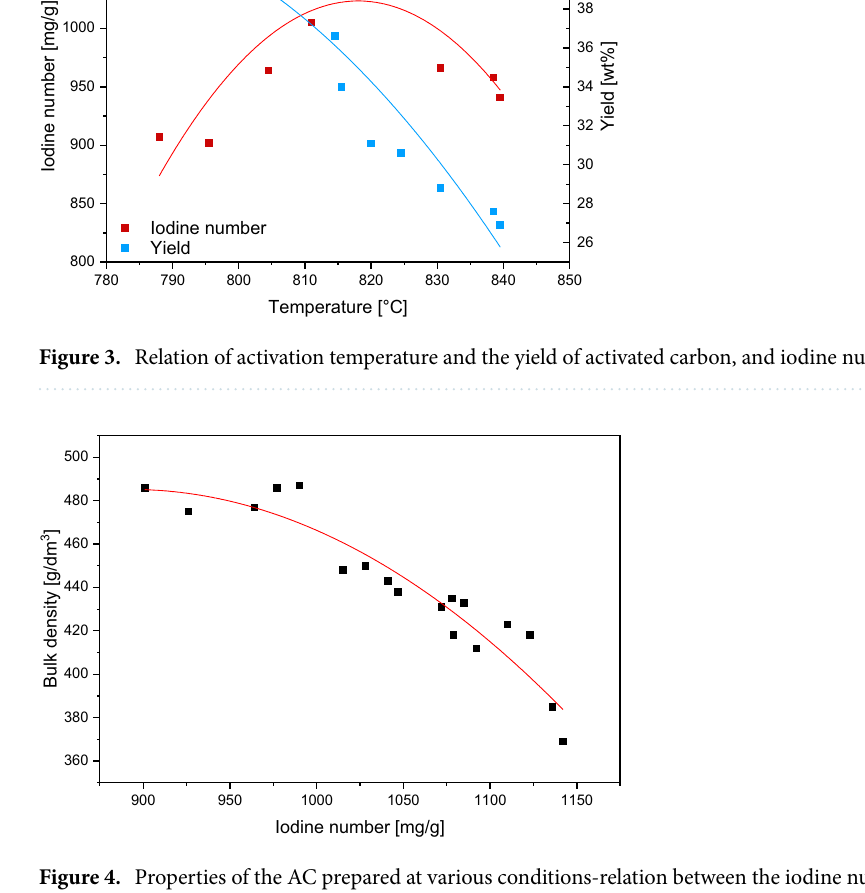
Figure 4. Properties of the AC prepared at various conditions-relation between the iodine number and bulk